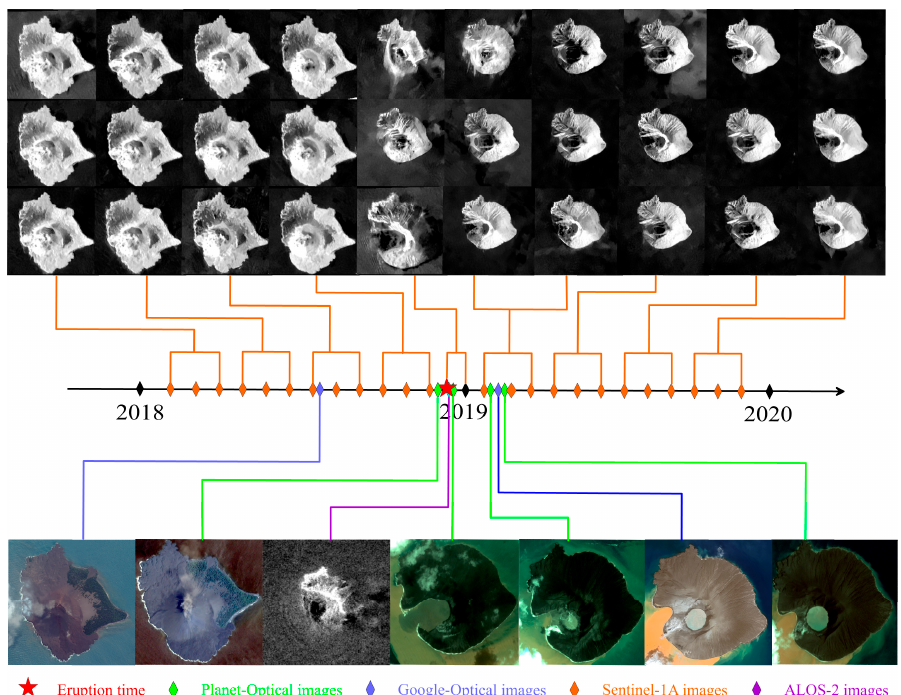
Figure 2. Time chart of the data used in this study, including Planet images, Google images, Senti- nel-1A images and ALOS-2 images.